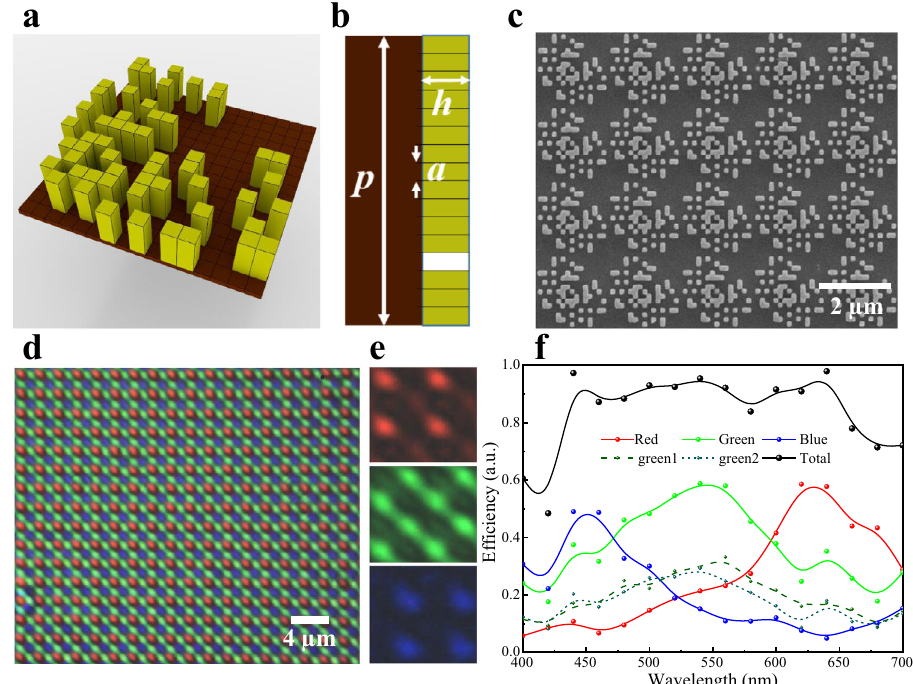
Fig. 3 Experimental veri fi cation of colour routing response. a Schematic of the optimised binary pattern of the MBCR with the unit cell size of 2 µ m × 2 µ m. The top layer Si 3 N 4 patterns on a quartz glass substrate with a thickness of 500 µ m. b Side view of the unit cell. Parameters of the MBCR are set as: h = 600 nm, a = 125 nm and p = 2 µ m. c SEM image of a fabricated sample. d Measured image at the imaging plane of the MBCR array when illuminated by a collimated white beam. e Three colour channels of imaging plane under the illumination of three colour light. f The measured colour collection ef fi ciencies of each channel in the visible region. Each colour curve corresponds to its colour channel. The black line represents the energy utilisation ef fi ciency.